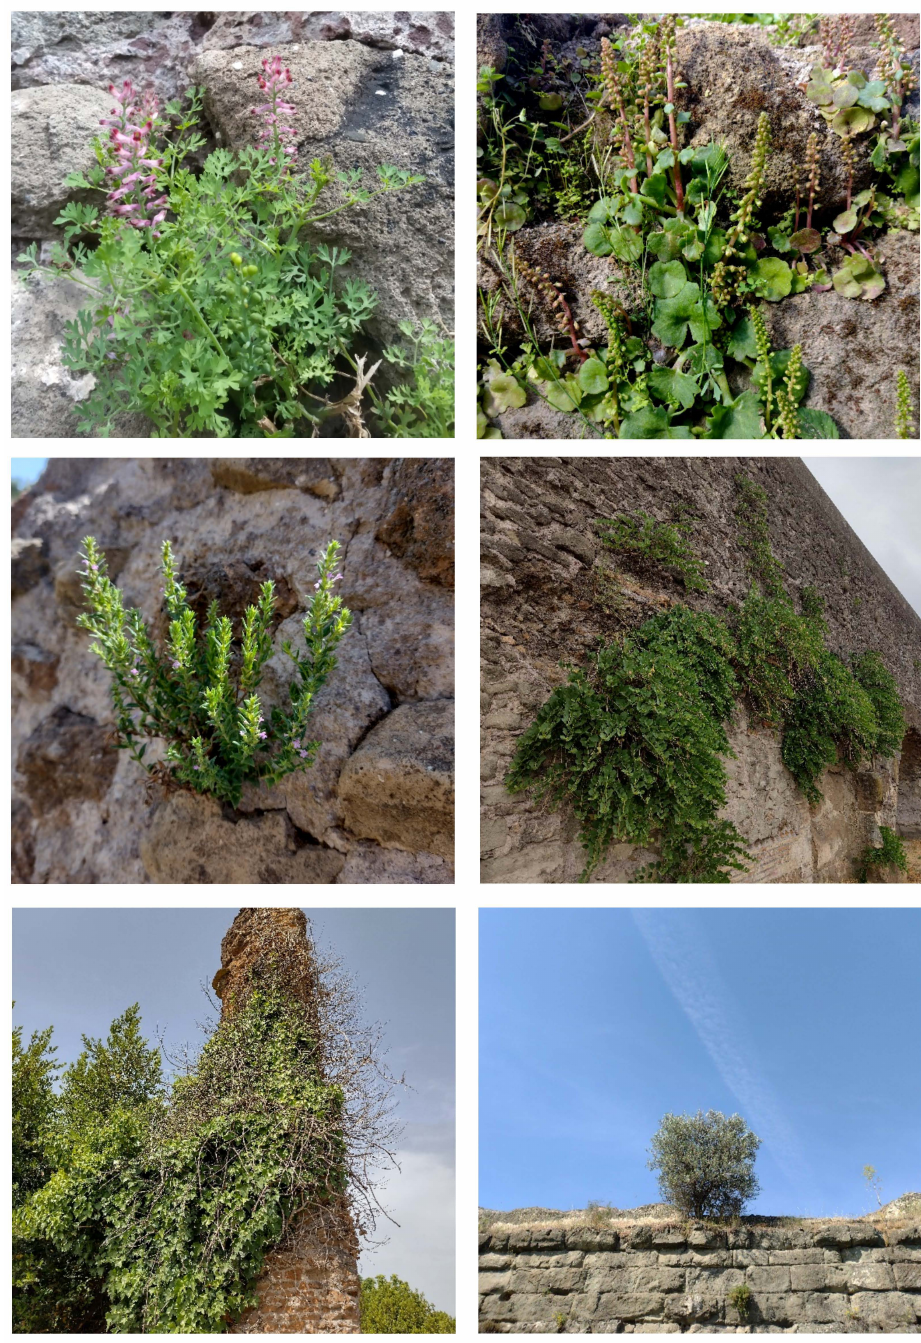
Figure 88. Fumaria officinalis subsp. officinalis on Felix’s Aqueduct (top-left photo); Umbilicus rupestris on the vertical wall of the aqueduct located in front of the Egeria nymphaeum, in Caffarella valley (top-right photo); Micromeria graeca on Claudio’s Aqueduct (central-left photo); Capparis orientalis on Felix’s Aqueduct (central-right photo); Hedera helix subsp. helix on Felix’s Aqueduct (bottom-left photo); Olea europaea on Claudio’s Aqueduct (bottom-right